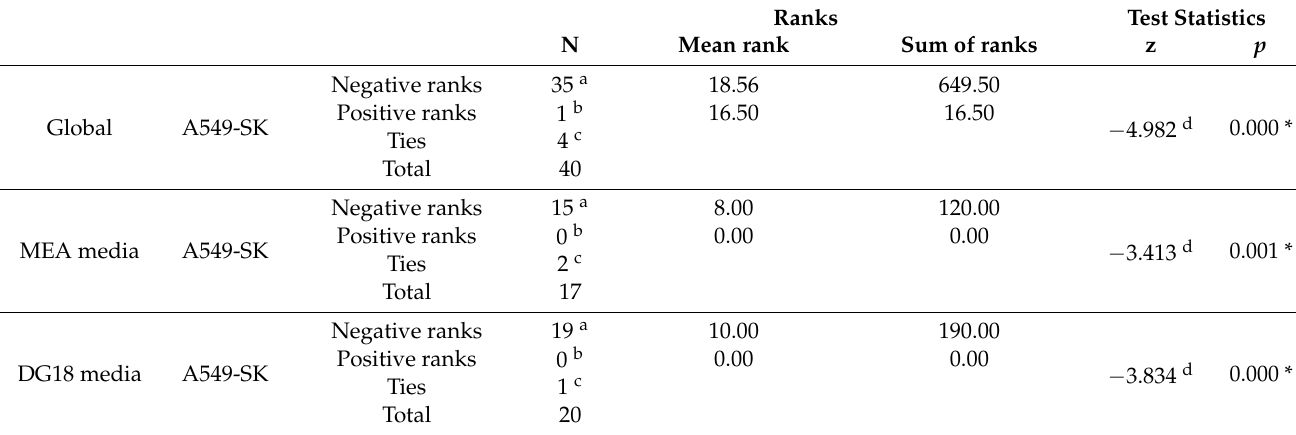
Table 5. Comparison of IC50 levels between SK and A549 cells from isolates first isolated on MEA and DG18. Wilcoxon test results.